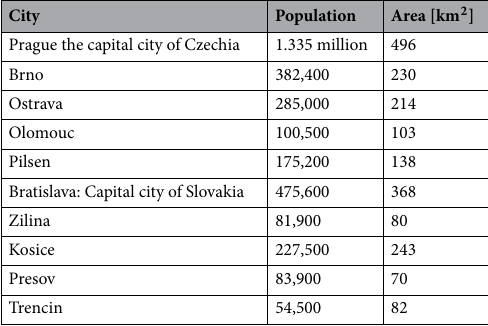
Table 1. List of selected cities.